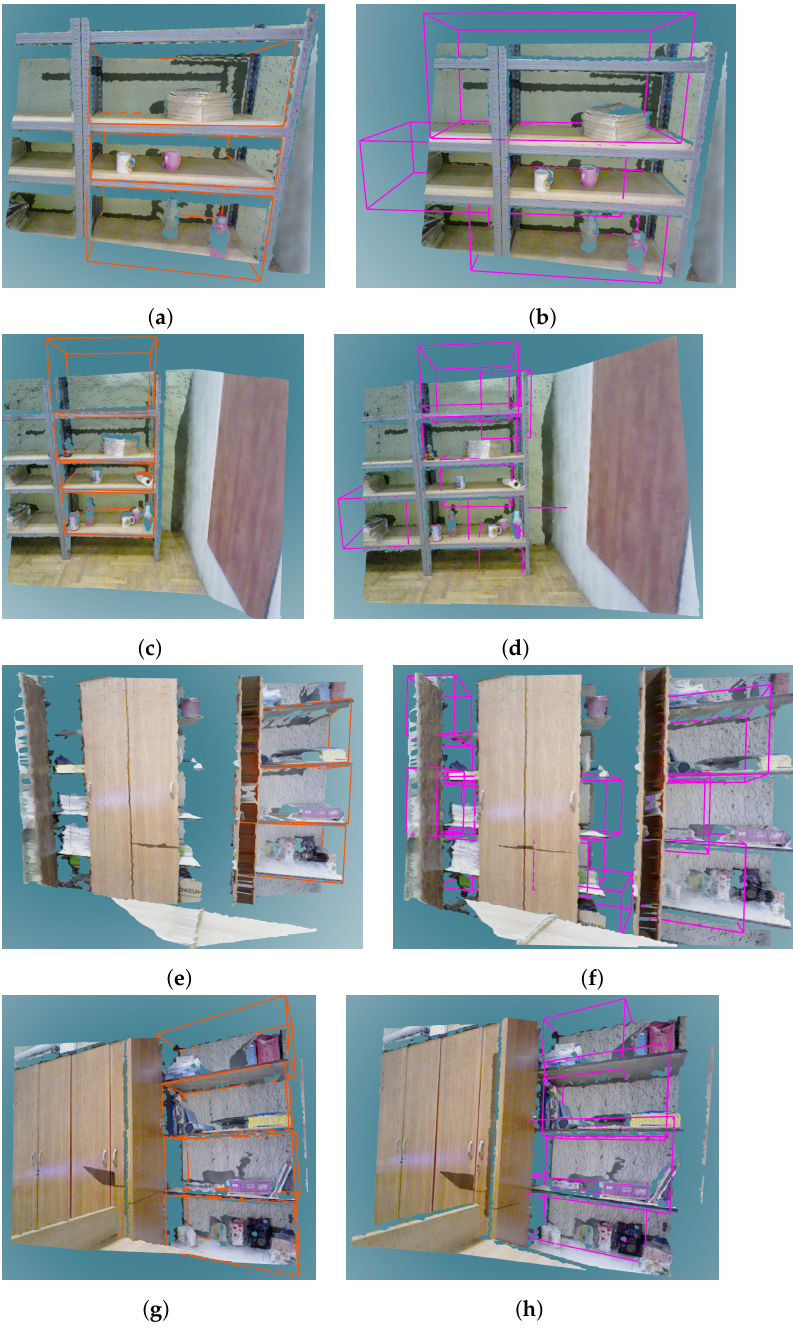
Figure 13. Examples of storage volumes in depth images contained in a real dataset. The left column shows ground truth annotation of storage volumes in the selected furniture classes. The right column shows the storage volumes predicted in these furniture models by the VoteNet detector. ( a , b ) Show a close-up view of a bookshelf, ( c , d ) Show a bookshelf seen from a distance, ( e , f ) Show a close-up view of a cabinet, ( g , h ) Show a cabinet seen from a